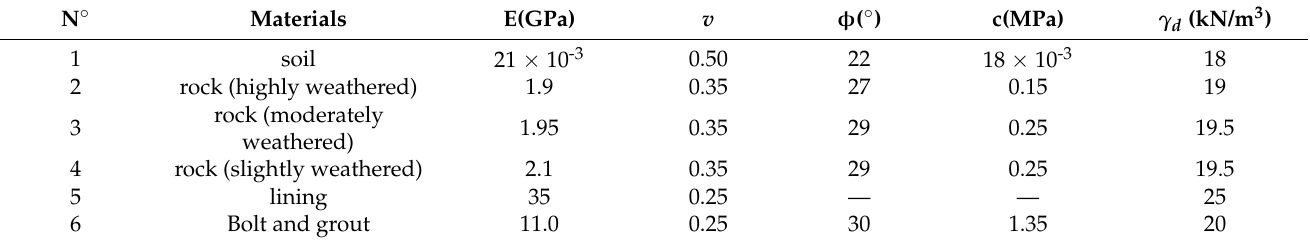
Table 1. Mechanical parameter of the Qijiazhuang tunnel.